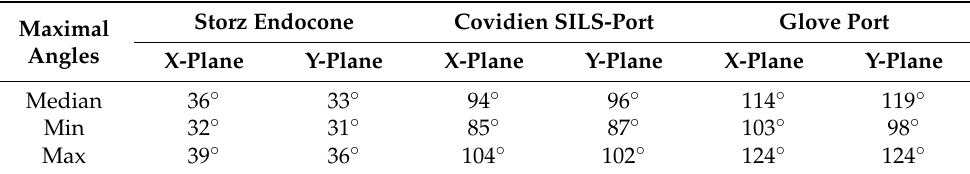
Figure 3. Example of rendered images of the volume of maneuverability (VoM). The upper line shows the VoM when only an endoscope was inserted into the ports. The lower row shows VoM when an endoscope and an instrument are inserted into the ports. ( a , d ) SILS-port; ( b , e ) Endocone; ( c , f ) glove port. The images were rendered in Blender (www.blender.org, accessed on 30 April 2018). Table 1. Maximal measured angles in the X- and Y-plane within the respective ports when a 100-mm endoscope was inserted.